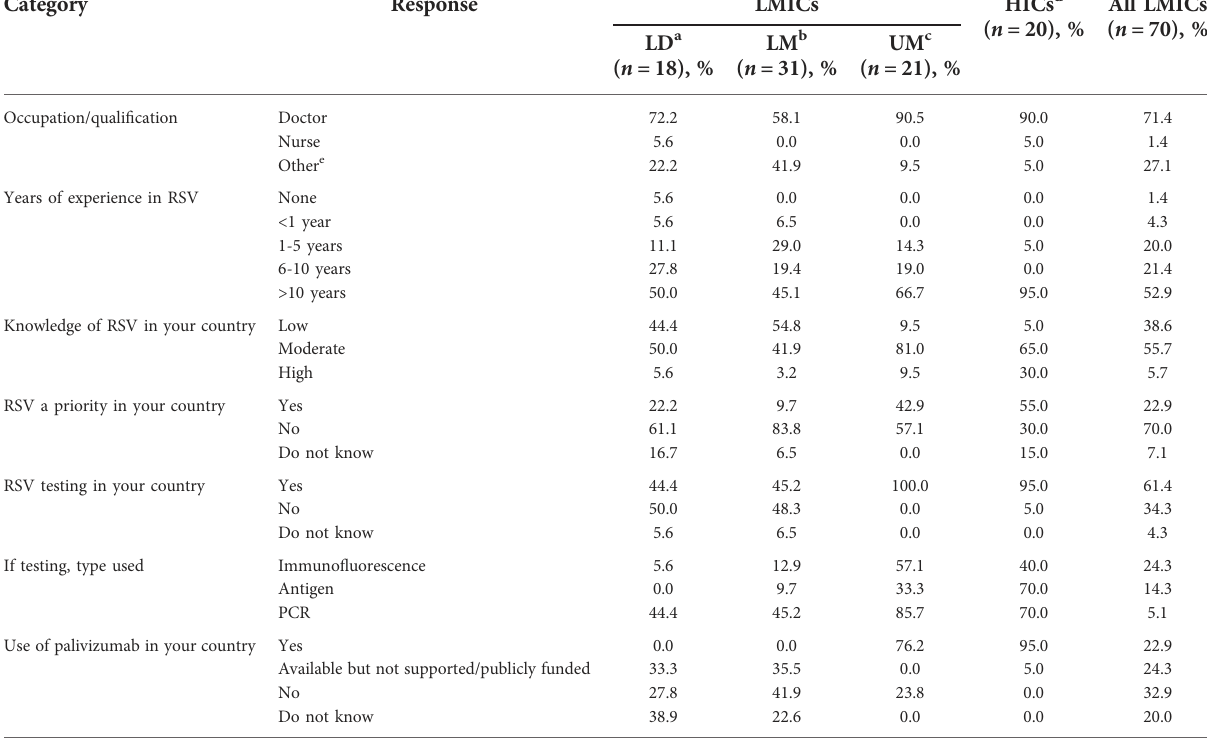
TABLE 1 Demographics and background information of respondents and the RSV situation in their countries.